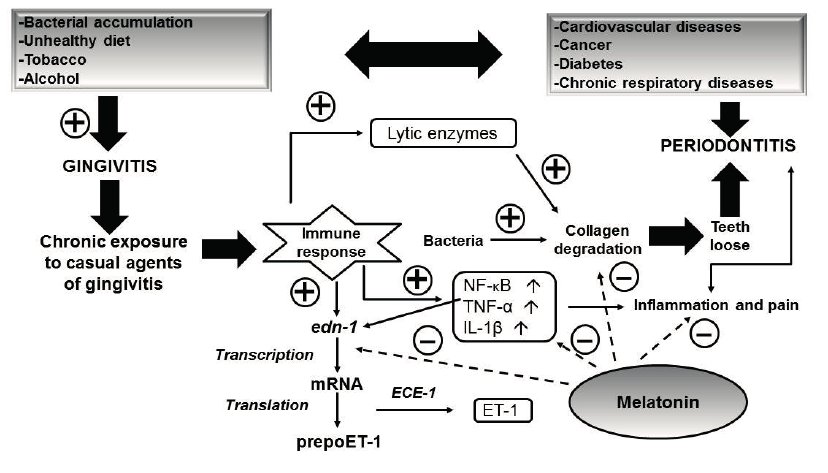
Figure 2. Diagram of the main mechanisms for the development of the oral diseases based on inflammation and oxidative stress: gingivitis and periodontitis and the role of MLT in their inhibition. Positive signs mean induction and negative inhibition. The line explains the cascade of reactions which relates gingivitis with periodontitis and involved exogenous and endogenous factors. The dotted line indicates where the activity of melatonin is